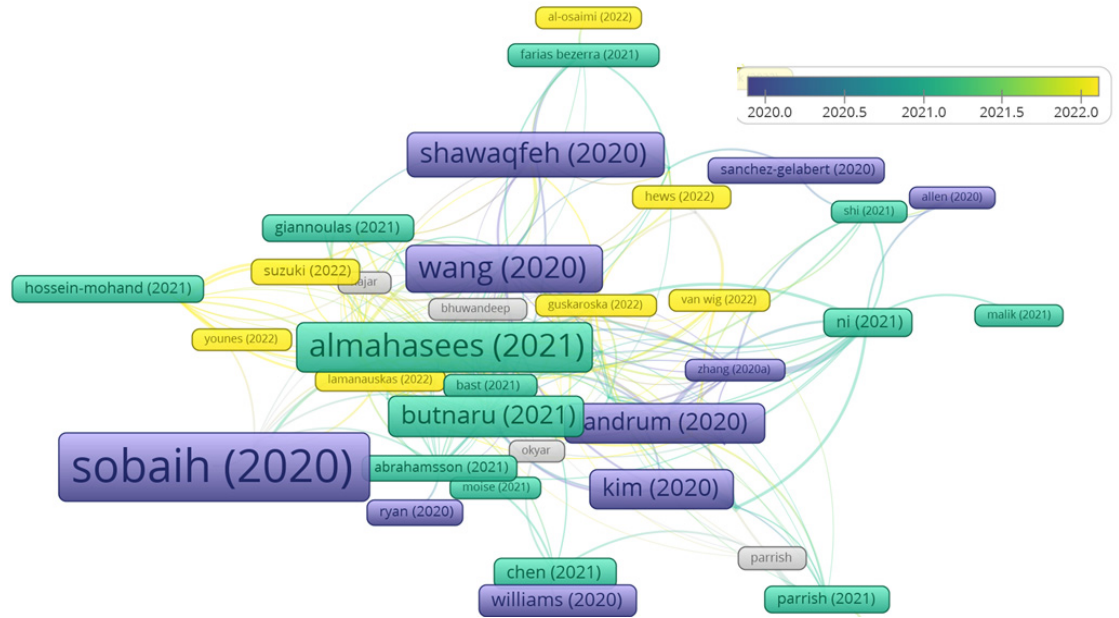
Figure 3. VOSviewer mapping of student perceptions of online education regarding citations. Source: authors’ own analysis with VOSviewer.